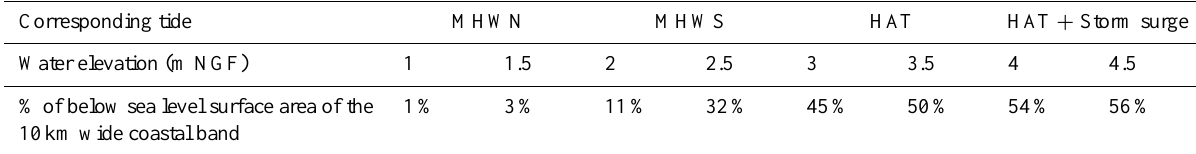
Table 1. Percentages of the 10km band land area (from the present-day coastline to 10km inshore) below: (1) the sea level of the mean high water neaps (MHWN); (2) the sea level of the mean high water springs (MHWS); and (3) the sea level of highest astronomical tide (HAT). Corresponding tide MHWN MHWS HAT HAT + Storm surge Water elevation (m NGF) % of below sea level surface area of the 10km wide coastal